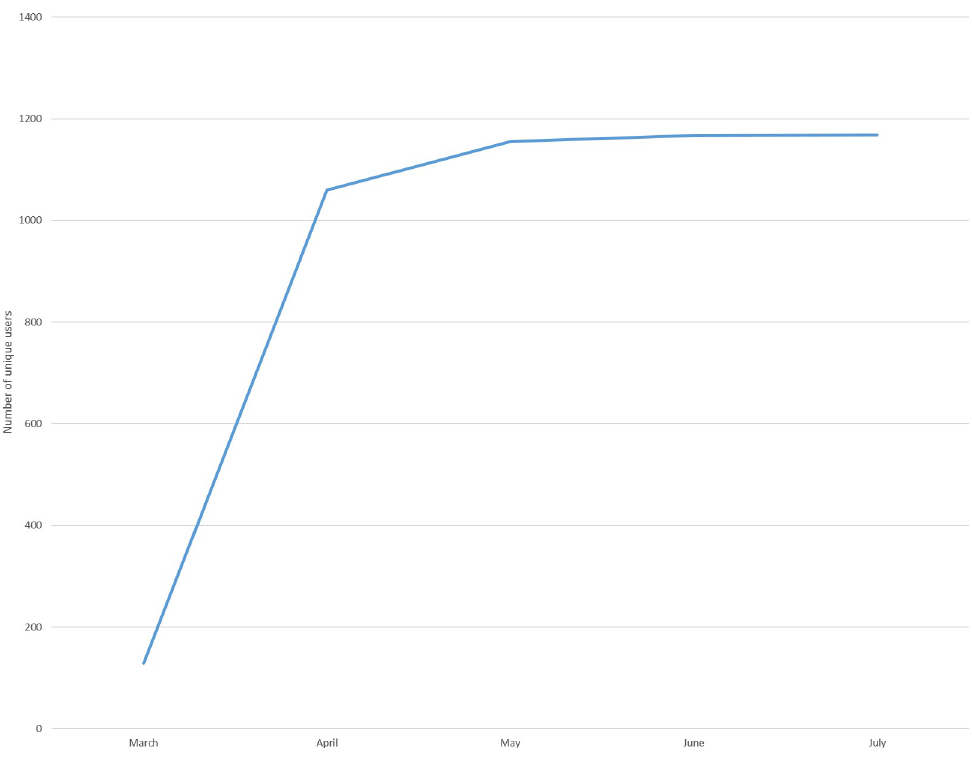
Fig 1. Monthly adoption rate of COVID-19 app from March 30, 2020 to July 8, 2020.